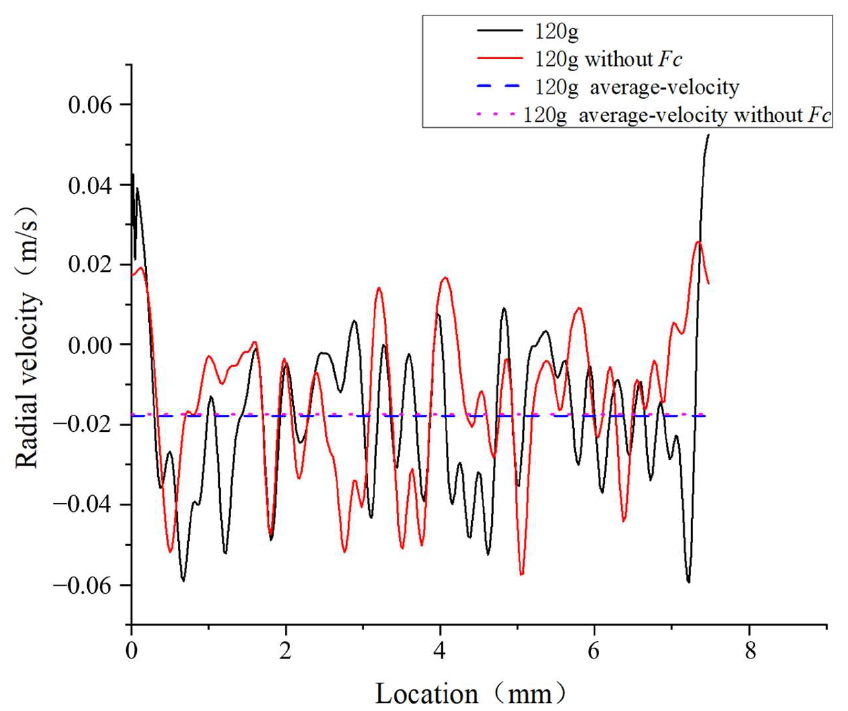
Figure 19. The radial velocity distribution along axis direction (120 g).